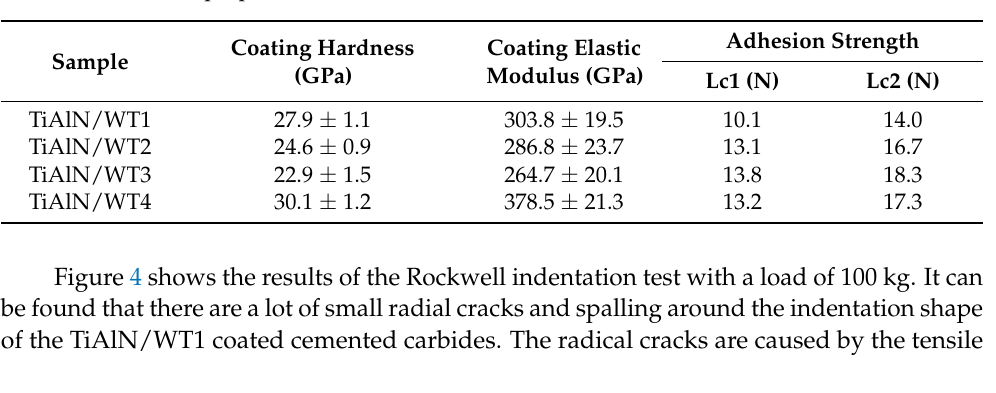
Figure 3. SEM fracture cross-sections of ( a ) TiAlN/WT1, ( b ) TiAlN/WT2, ( c ) TiAlN/WT3 and ( d ) TiAlN/WT4 coated cemented carbides.